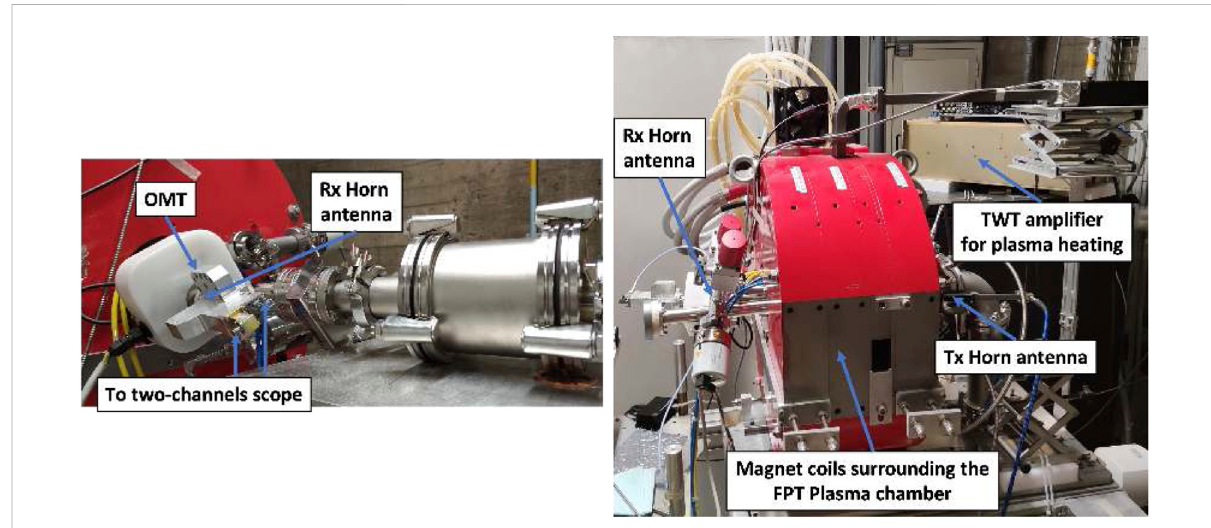
FIGURE 10 Pictures of the Flexible Plasma Trap (FPT) testbenchshowing the two Ka-band conical horn antennas and the two portsof the OMT connected to the 20 GHz 80 GS/s (40 Gs/s in this case since the detection is performed on the two channels, simultaneously) scope.